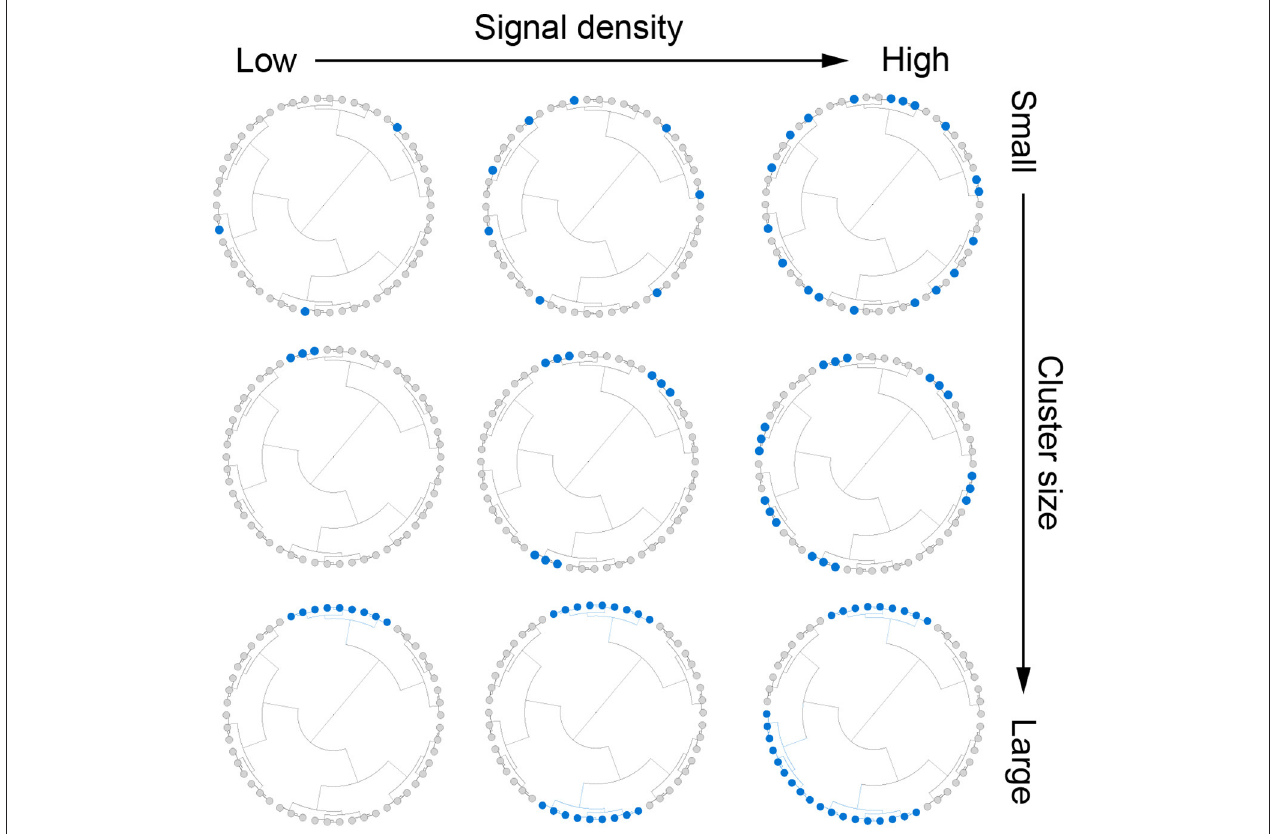
FIGURE 1 | Illustration for the simulation strategy. We simulate outcome-associated OTU clusters (aClusters) of different cluster size ( top to bottom ) and signal density ( left to right ). We also vary the abundance level of the aClusters (not